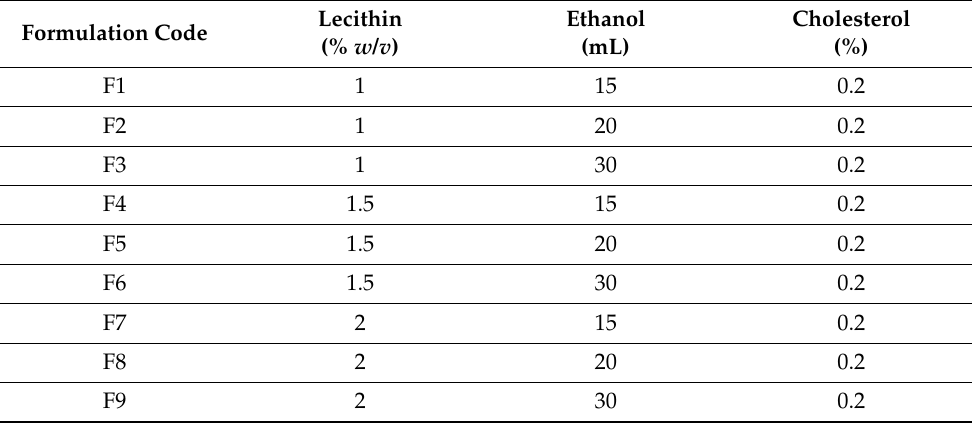
Table 8. Formulation of P. granatum ethosome. Formulation